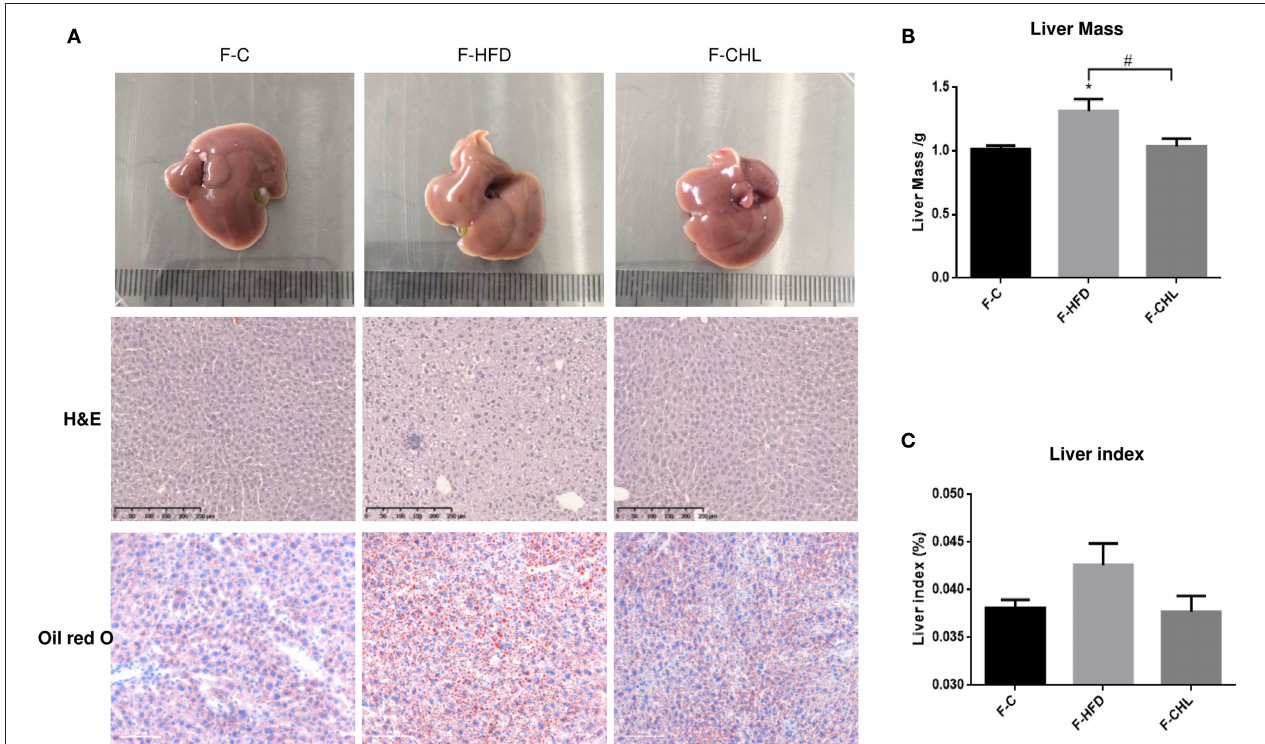
FIGURE 11 | Fecal flora transplant from CHL-treated mice attenuates hepatic steatosis of the mice fed with an HFD. (A) Fecal transplant, as mentioned in the section, Materials and methods. Liver images, HandE staining of the liver, and Oil Red O staining of the liver tissues. (B) Liver mass. (C) Liver index and n = 6 for each group. Values are mean ± SEM; * p < 0.05 vs. Ctrl group; # p < 0.05 vs/ HFD group.